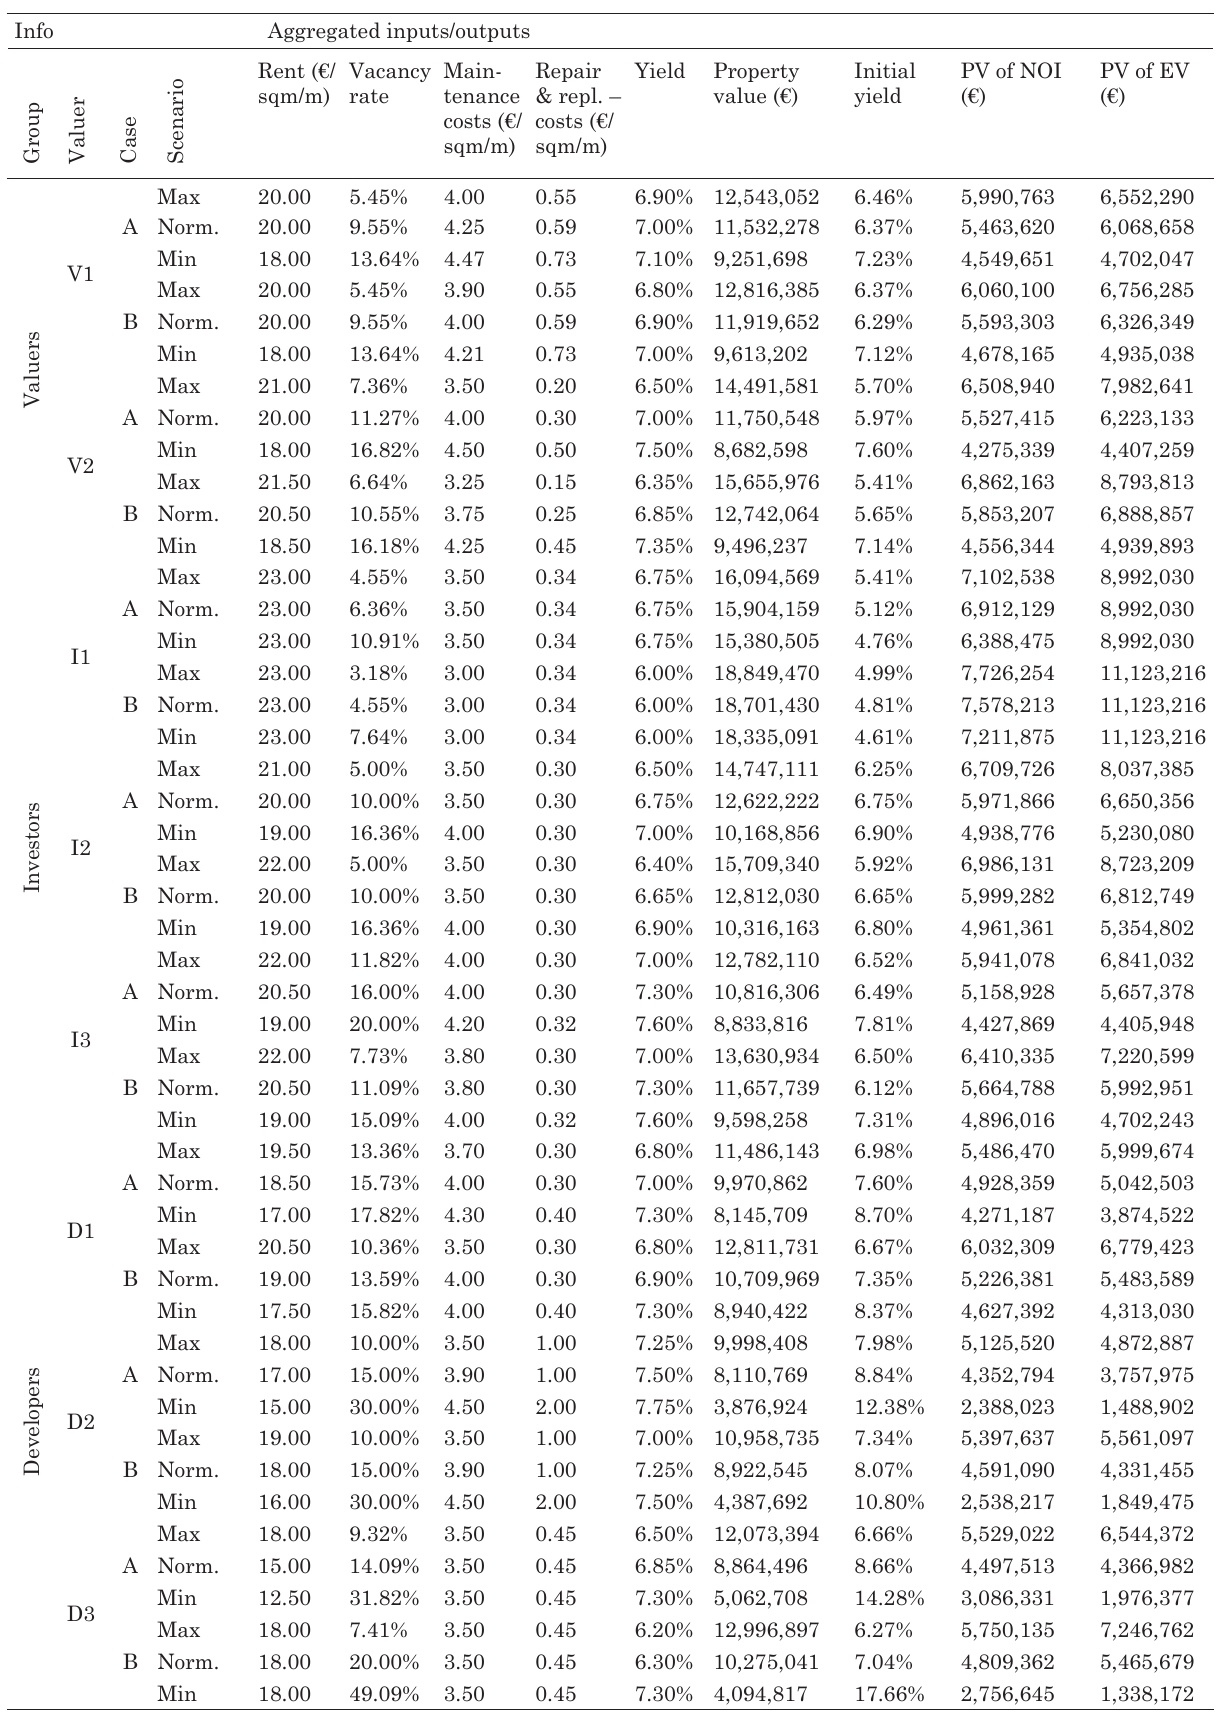
Table 2. Aggregated inputs/outputs of DCF parameters from all of the responses Info Aggregated inputs/outputs